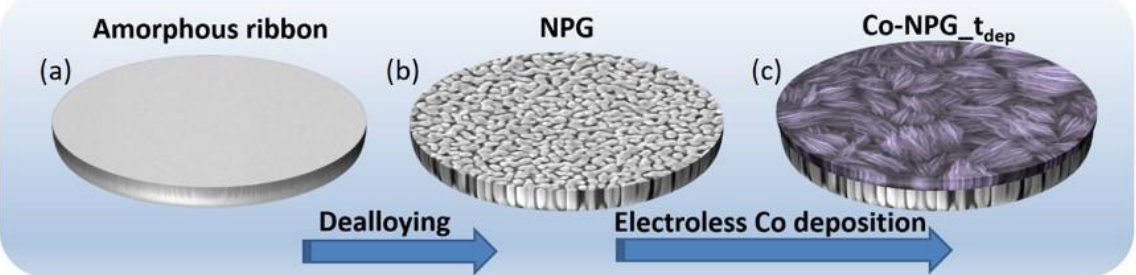
Figure 1. Scheme of the procedure followed to obtain Co-NPG_t dep . ( a ) Synthesis of the amorphous ribbon through melt spinning process; ( b ) dealloying process to obtain NPG; ( c ) electroless Co deposition onto NPG at selected times.